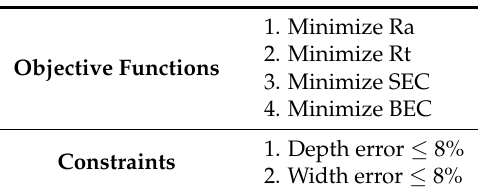
Table 4. Optimization model used for the study.